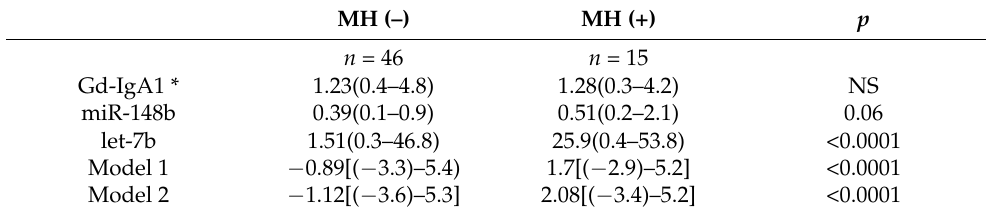
Table 3. Differences in Gd-IgA1, miR-148, and let-7b serum levels at time of renal biopsy, and calculated models between patients with and without